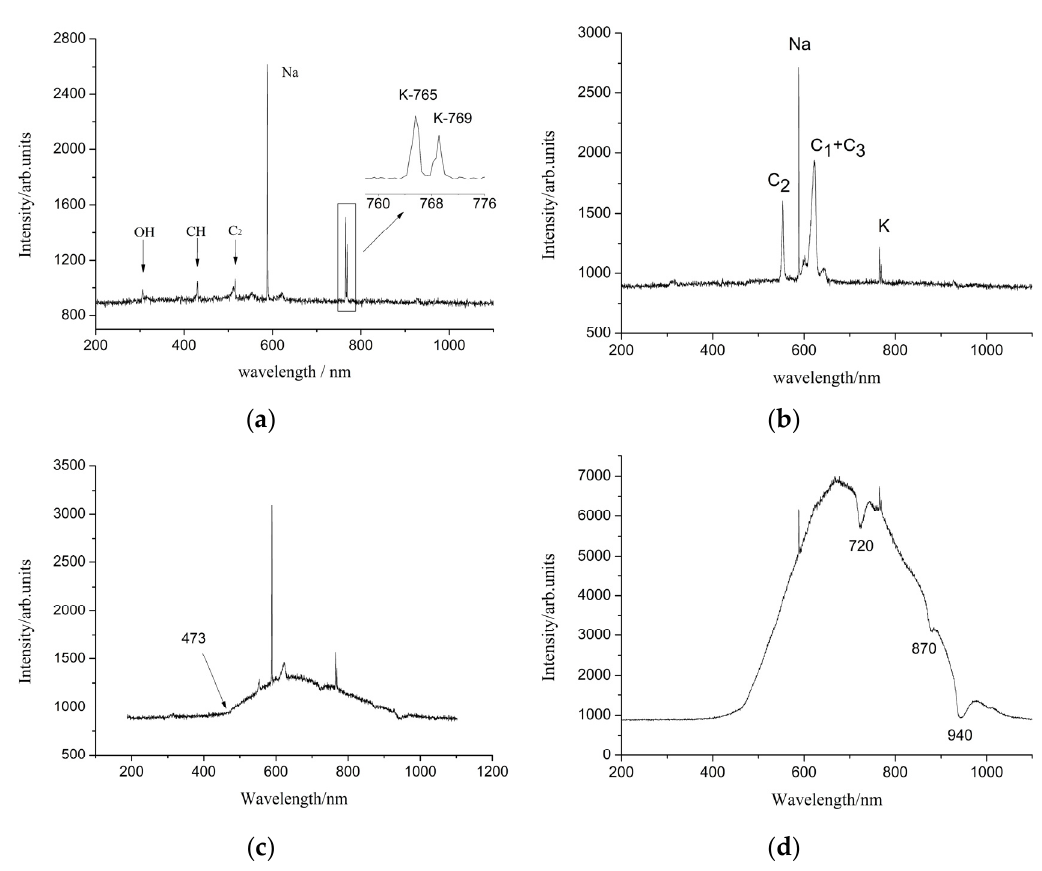
Figure 10. Radiation spectrum of detonation flame at different times: ( a ) 0 ms; ( b ) 10 ms; ( c ) 20 ms; ( d ) 50 ms.